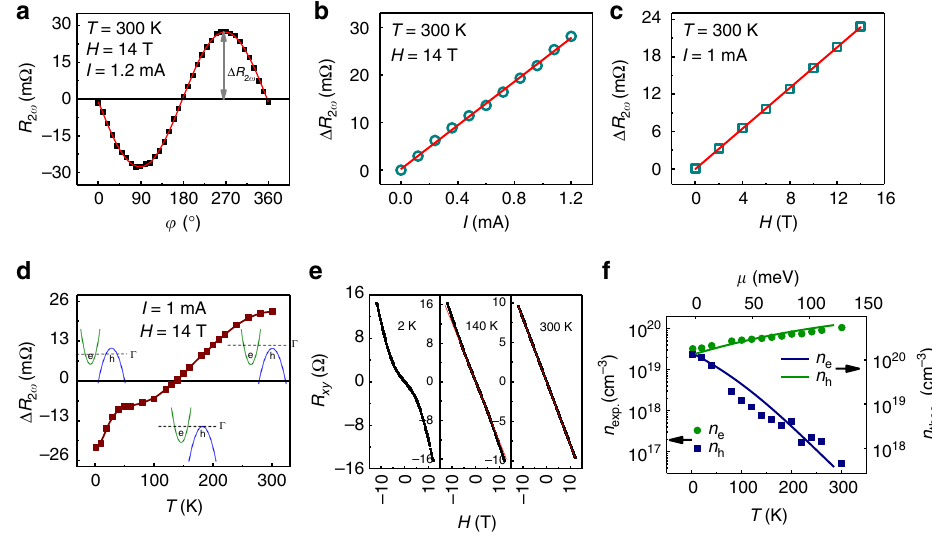
Fig. 2 Nonlinear magnetoresistance with a temperature-driven inversion in WTe 2 . a Angular-dependent second-harmonic resistance R 2 ω measured at T = 300 K for a 34 nm thick WTe 2 device with the current applied at 45° from the a axis of WTe 2 crystal. The solid line is a sinusoidal fi t ( − Δ R 2 ω sin φ ) to the data. A vertical offset was subtracted for clarity. b , c Current I ( b ) and magnetic fi eld H ( c ) dependence of the sinusoidal amplitude Δ R 2 ω at room temperature. The solid lines are linear fi ts to the data. d Δ R 2 ω extracted at different temperatures under H = 14 T and I = 1 mA. The insets illustrate the position of the Fermi level in different temperature ranges. ‘ e ’ and ‘ h ’ indicates the electron and hole pocket, respectively. e Field dependence of the Hall resistance R xy at three representative temperatures (red lines are to guide the eye). f Experimental temperature dependence of the electron n e and hole n h densities (points, bottom and left axes), overlaid with the Fermi level dependence of n e and n h as calculated ab-initio (lines, top and right